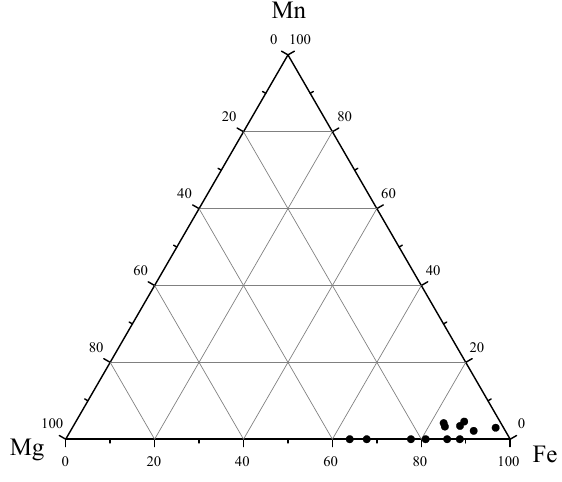
Figure 4. Ternary plot of the Fe–Mg–Mn contents (in wt%) of the blue to black mineral aggregates isolated from sediments below the SMTZ. These data were derived from multiple EDS